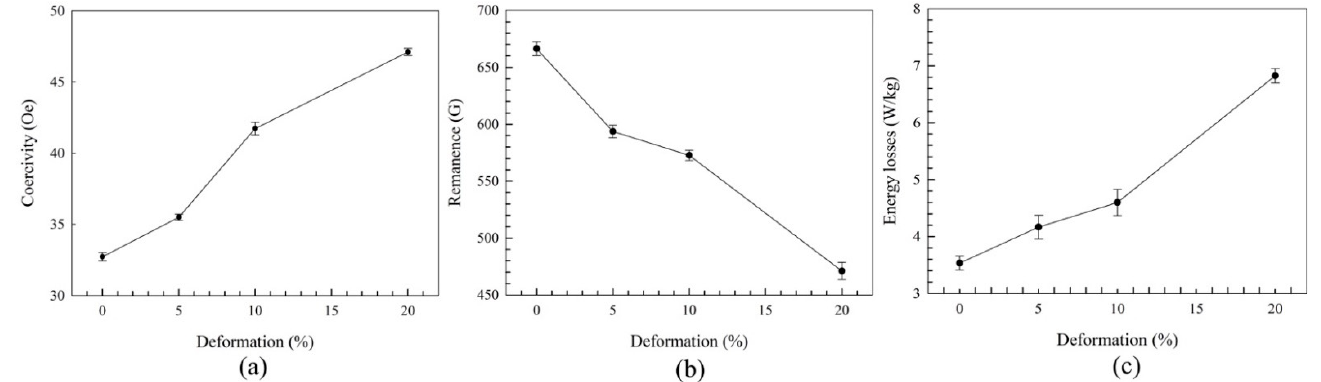
Figure 2. Effect of deformation on the magnetic properties of steel: ( a ) coercive field, ( b ) remanence, ( c ) energy losses.